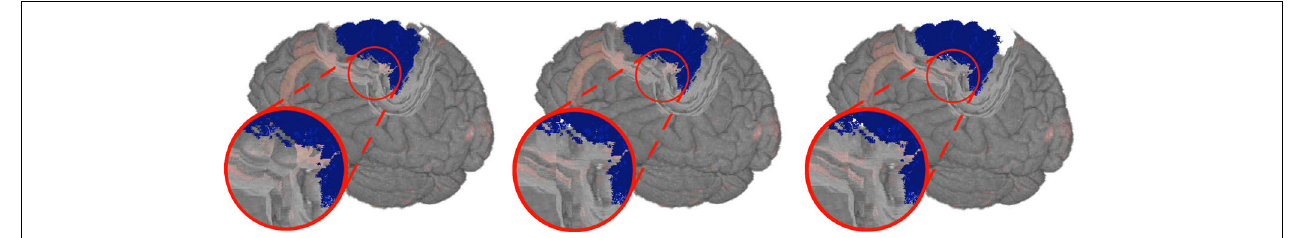
FIGURE 6 | Clipping artifacts depend on the definition of the distance value and are clearly visible when observing transitions in the sulci (dark gray) in the detail view. Left: Circular artifacts when using the closest